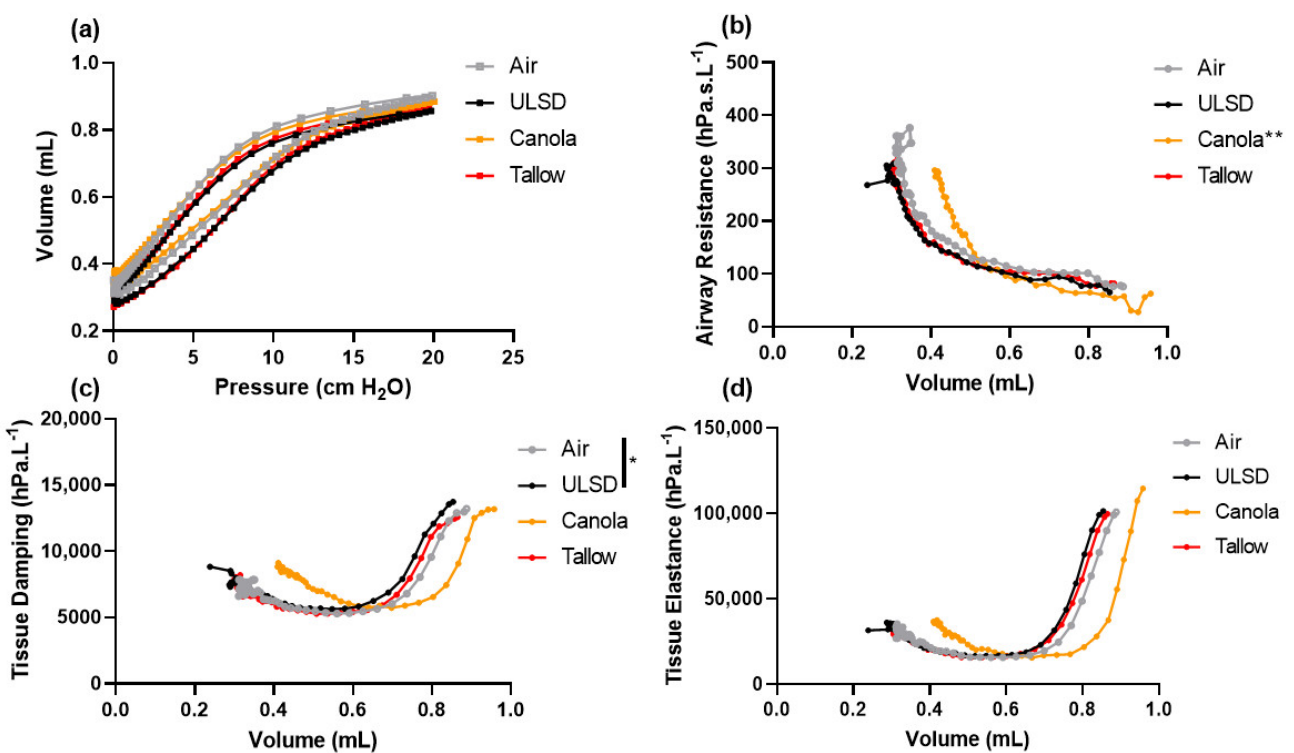
Figure 3. ( a ) Pressure–volume loops for mice exposed to Air (A), ULSD (U), Canola (C), or Tallow (T) biodiesel exhaust for 2 h/day for 8 days and volume dependence of lung function for ( b ) airway resistance, ( c ) tissue damping, and ( d ) tissue elastance for mice exposed to Air, ULSD, Canola, or Tallow biodiesel exhaust for 2h/day for 8 days. Data are group means. n = 23 for all groups except ULSD ( n = 22) and Tallow ( n = 21). Differences between groups were analyzed statistically at P rs = 20 cm H 2 O or a lung volume of 0.7 mL, representing the highest volume for which data were available for each individual (* = p < 0.05, ** = p < 0.01, significant * values not located next to a line indicate that the group is significantly different to all other exposures). Data were analyzed using general linear modeling methodologies.